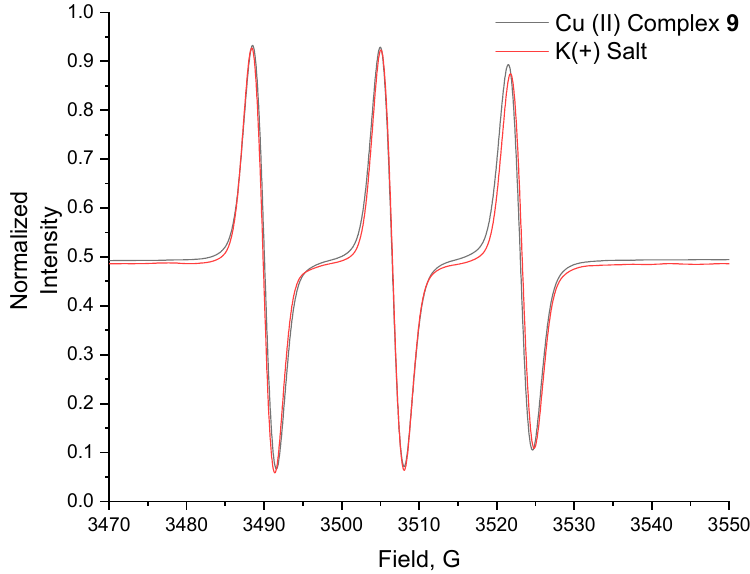
Figure 2. EPR spectra of the nitroxide part of the Cu(II) complex 9 and the in situ obtained potassium salt of TEMPO-containing 5-phenyl-2,2 ′ -bipyridine-6-carboxylic acid in a water: ethanol (1:1) mixture at r.t.